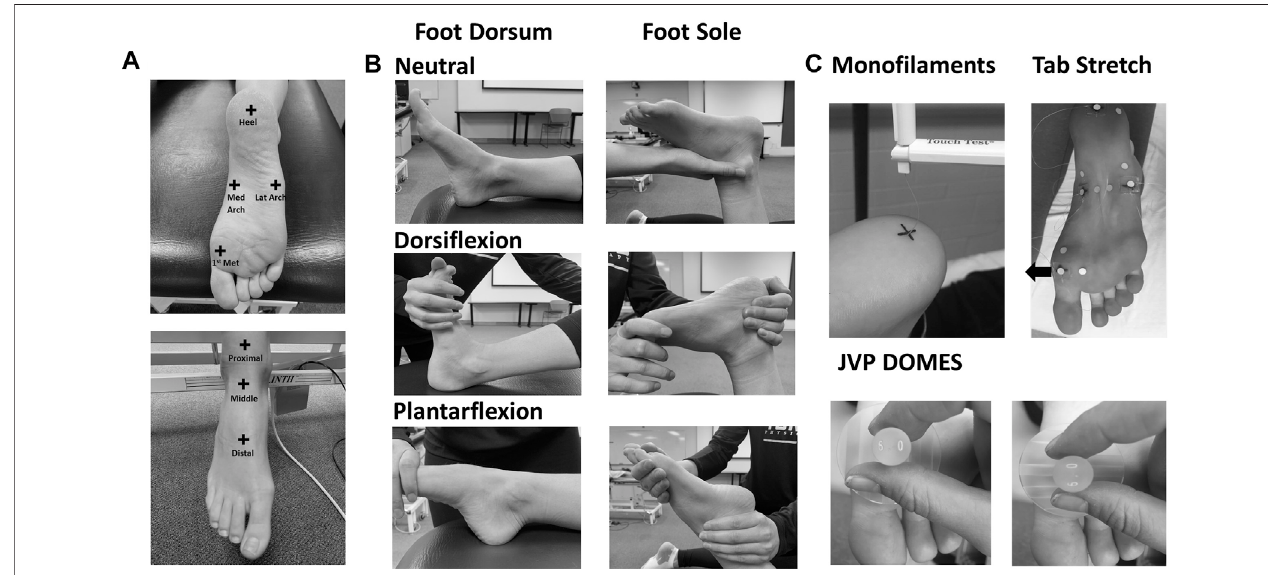
FIGURE 1 | (A) Test sites on the foot sole and dorsum. (B) Foot positions in the neutral, dorsi fl exion, and plantar fl exion posture throughout testing on the foot sole and dorsum. (C) Skin touch sensitivity (mono fi laments), stretch (tab stretch), and special acuity (JVP domes) sensitivity testing